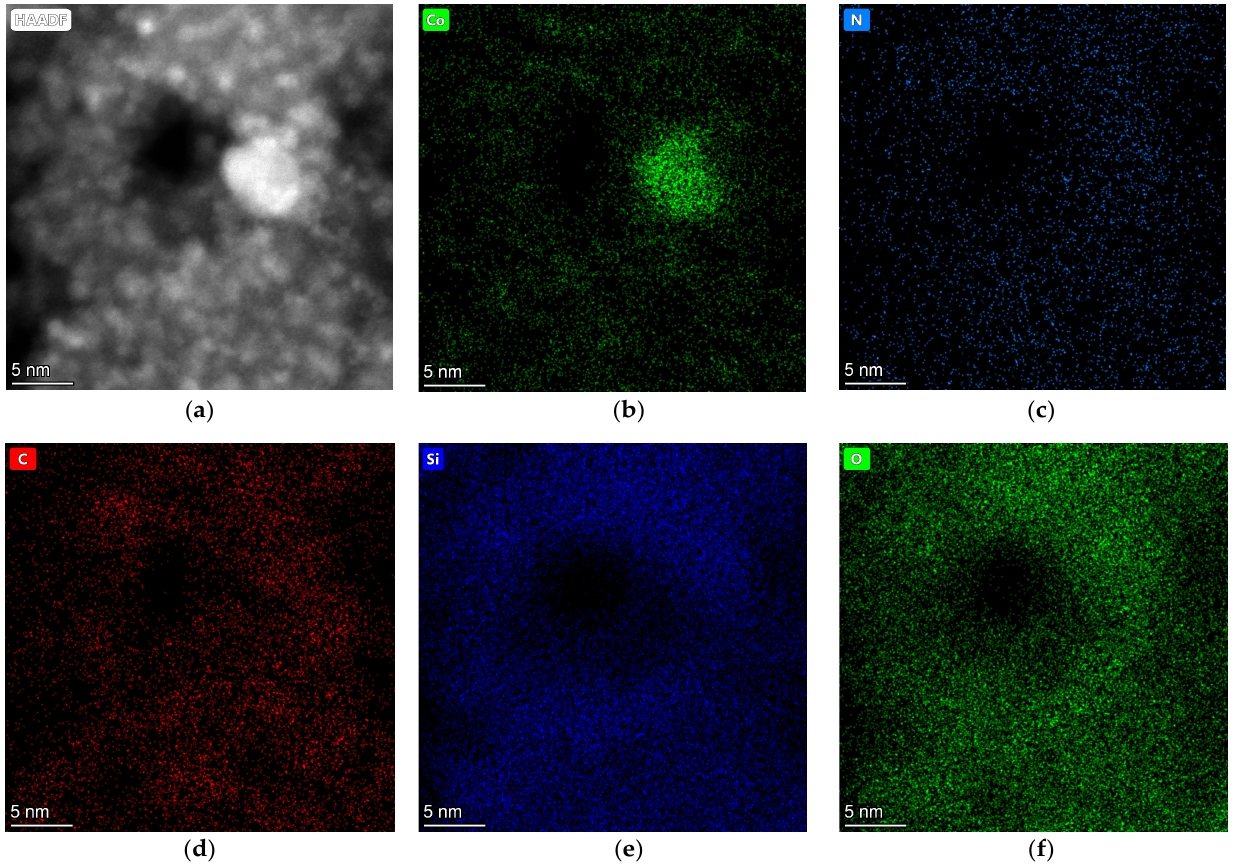
Figure 2. Low ( a ) and higher ( b – d ) magnification TEM images of as-synthesized Co-N-C/SiO 2 cat- alyst, confirming the presence of metallic cobalt particles of different sizes, ( d ) CoO x on their sur- face (interlayer spacing of 0.24 nm) and ( c ) fragments of graphitic carbon (interlayer spacing of 0.37 nm).